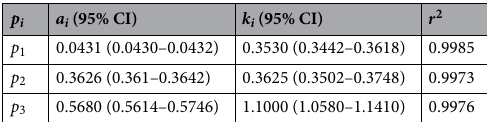
Table 2. The parameters for p i